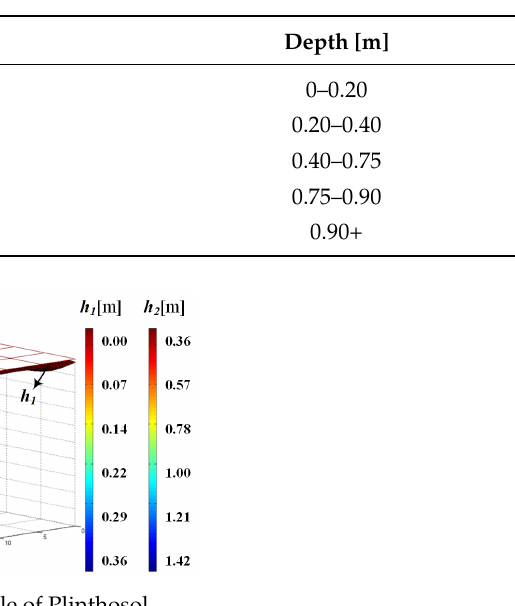
Table 5. Pedogenetics horizons of Plinthosol.